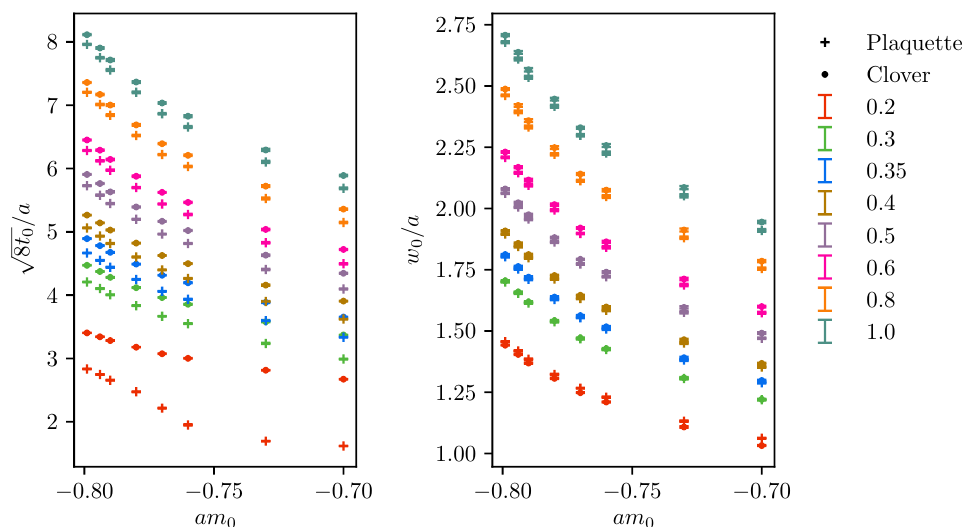
Figure 1. Gradient (cid:13)ow scales t 0 (left panel) and w 0 (right panel) as a function of the bare quark mass am 0 , for (cid:12) = 7 : 2. Di(cid:11)erent symbols denote the di(cid:11)erent de(cid:12)nitions of an action density (plaquette or clover). Di(cid:11)erent colours denote the reference values chosen for E 0 and W 0 . The choices of mass and coupling identify the ensembles from table